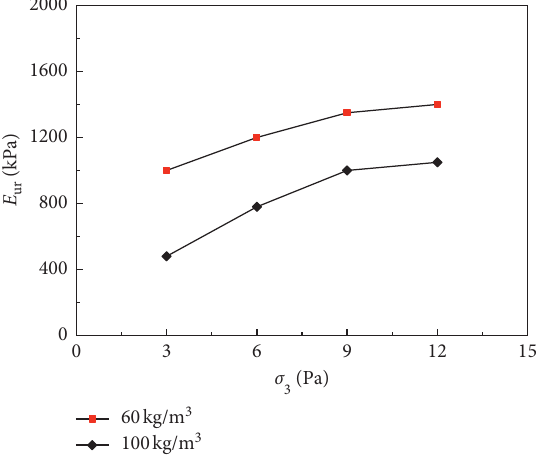
Figure 10: Relationship between the modulus of resilience, E confining pressure, σ 3